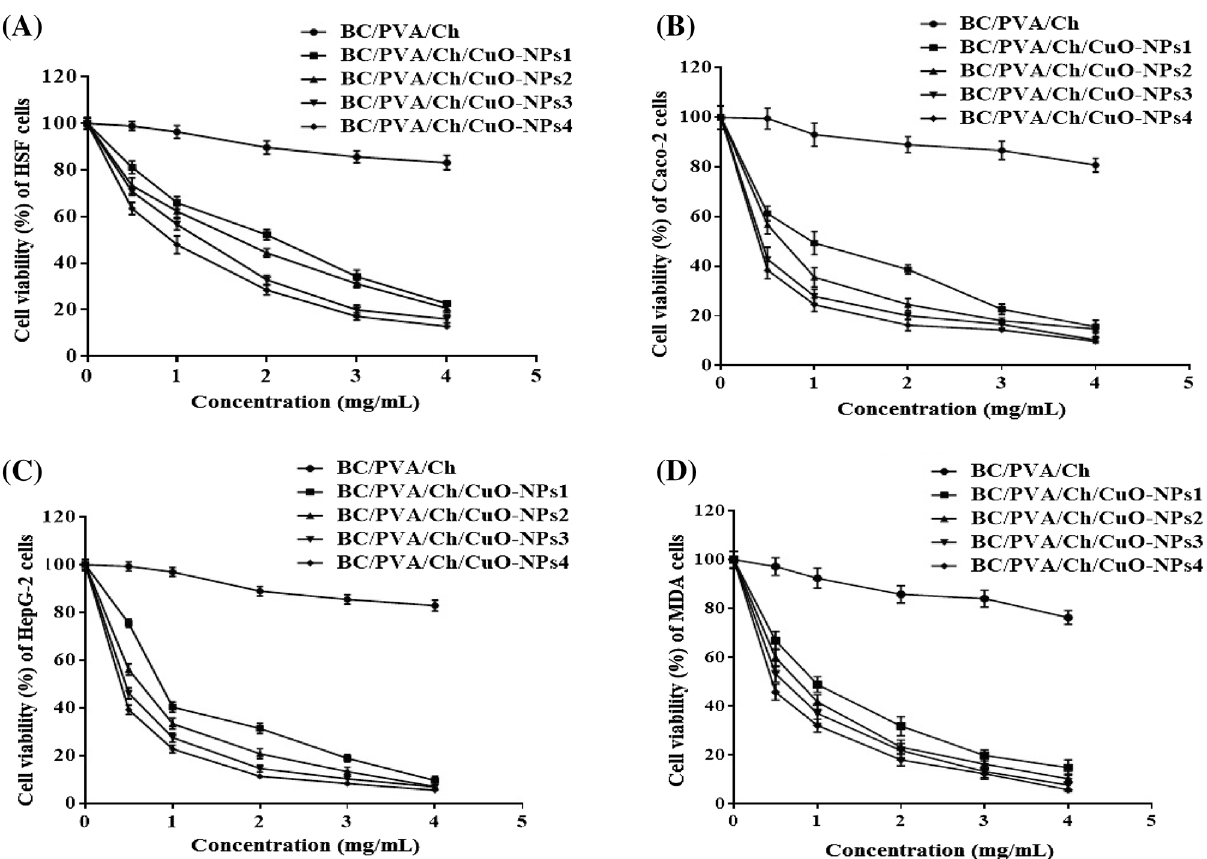
Figure 13. Effect of BC/PVA/Ch at four CuO-NPs concentrations on the cell viability of both normal and cancer cells. Normal HSF cells ( A ) and cancer cell lines of Caco-2 ( B ), HepG-2 ( C ), and MDA ( D ) cells were incubated with discs of the prepared composites at various weights of 0–4.0 mg/mL for 48 h and the viability of all tested cells was assayed by MTT method. All values are representing the average values from three experimental trials and expressed as mean ±